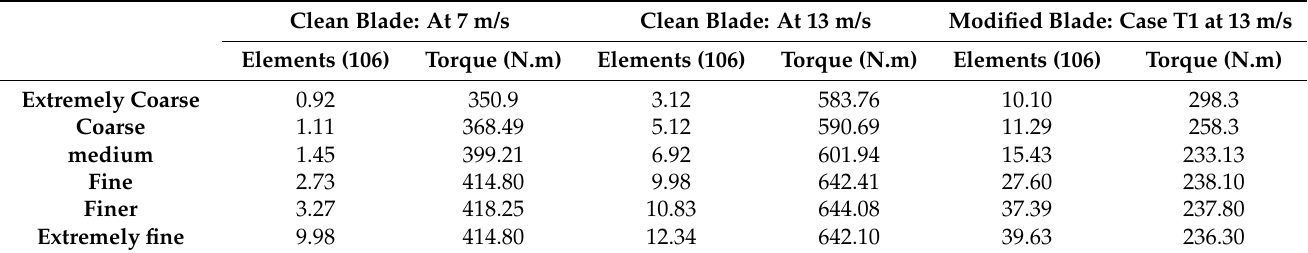
Table 7. grid independence of an unstructured mesh.